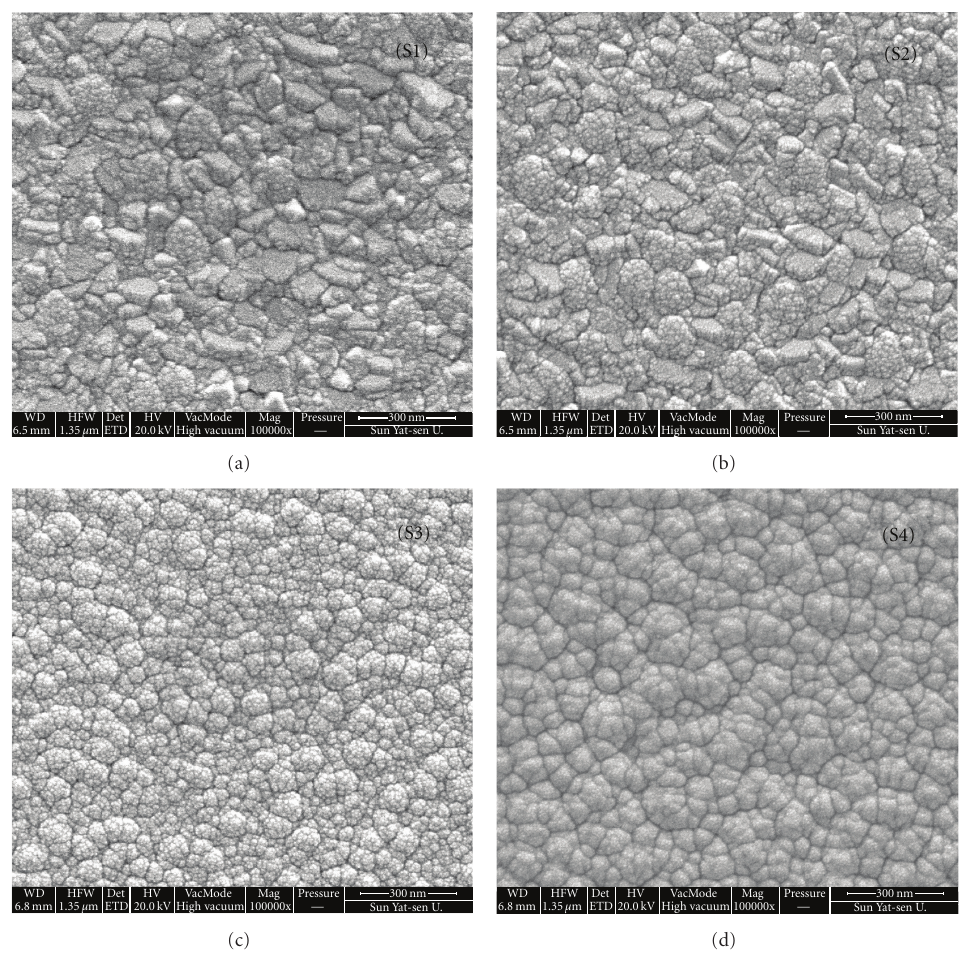
Figure 1: Typical SEM images of the surface images of TiO 2 thin films doped with La 2 O 3 with various concentrations (a) S1; (b) S2; (c) S3; and (d)